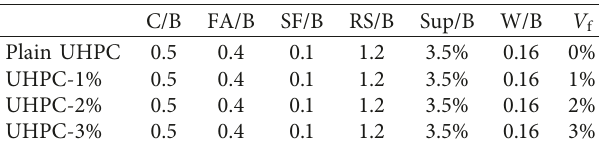
Table 2: Mixture proportion of